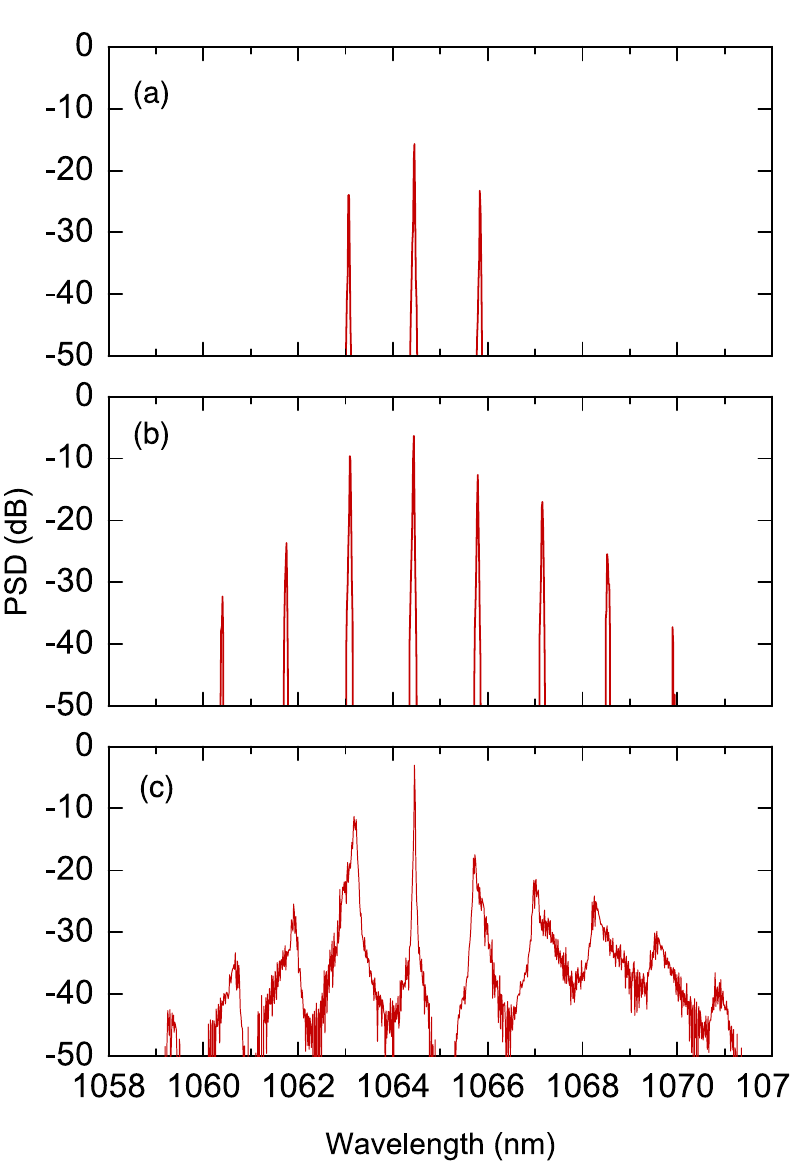
Figure 2. Optical spectral power around the fundamental mode for ( a ) 170 mW, ( b ) 2 W, and ( c ) 9 W of input powers. Adapted with permission from [48]. Copyrighted by the American Physical